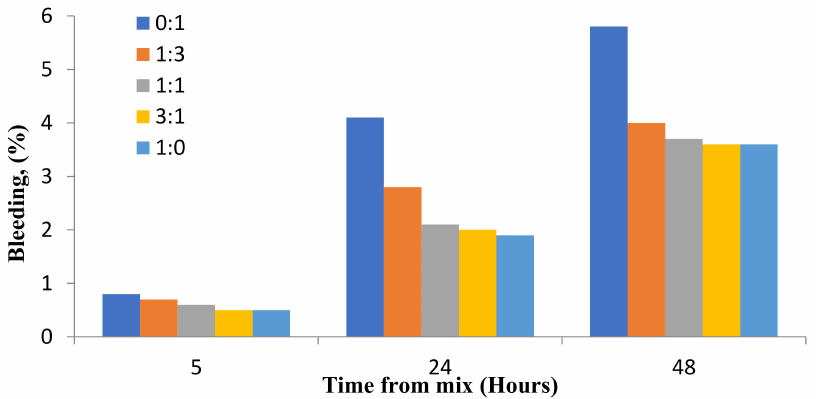
Figure 13. Effect of FA on water bleeding [208]. (Modified with improvement from